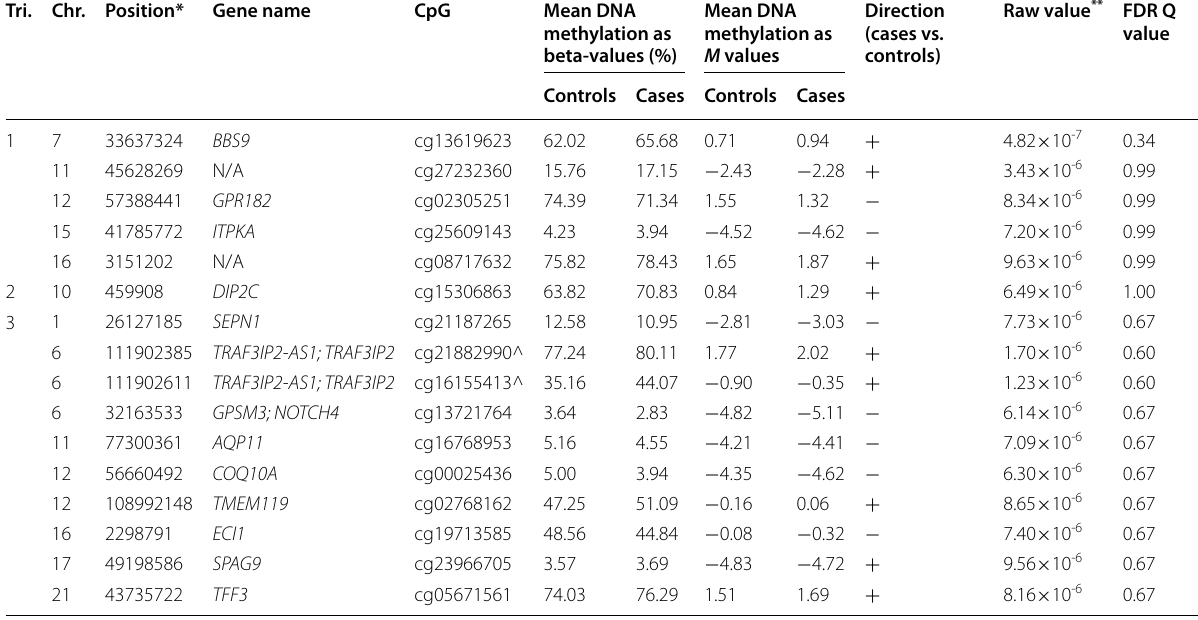
Table ordered by trimester, chromosome, and position; FDR Q value indicates the expected proportion of false positives among all significant probes Chr. chromosome, Tri . trimester, N/A this CpG site is not annotated to any genes under Illumina UCSC annotation * Position based on Human Genome Build 37 (hg19) ** Raw p values generated from linear regression analyses (DNA methylation regressed on case-control status and trimester-specific surrogate variables) ^ Sites carried forward for replication testing. Direction (cases vs. controls) “ ” indicates that DNA methylation values are higher in cases compared to controls while “ + controls